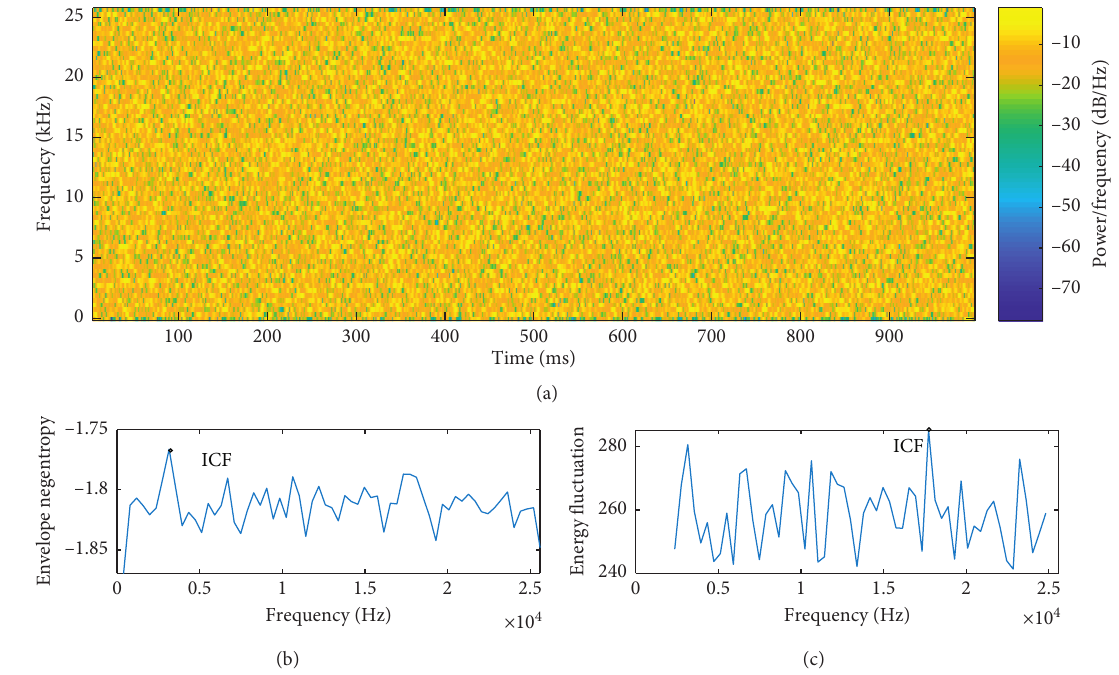
Figure 16: Spectral analysis of the experimental data in Figure 14(a) at window length 384 and overlap rate 90%: (a) TFR, (b) ENS, (c) EFS.